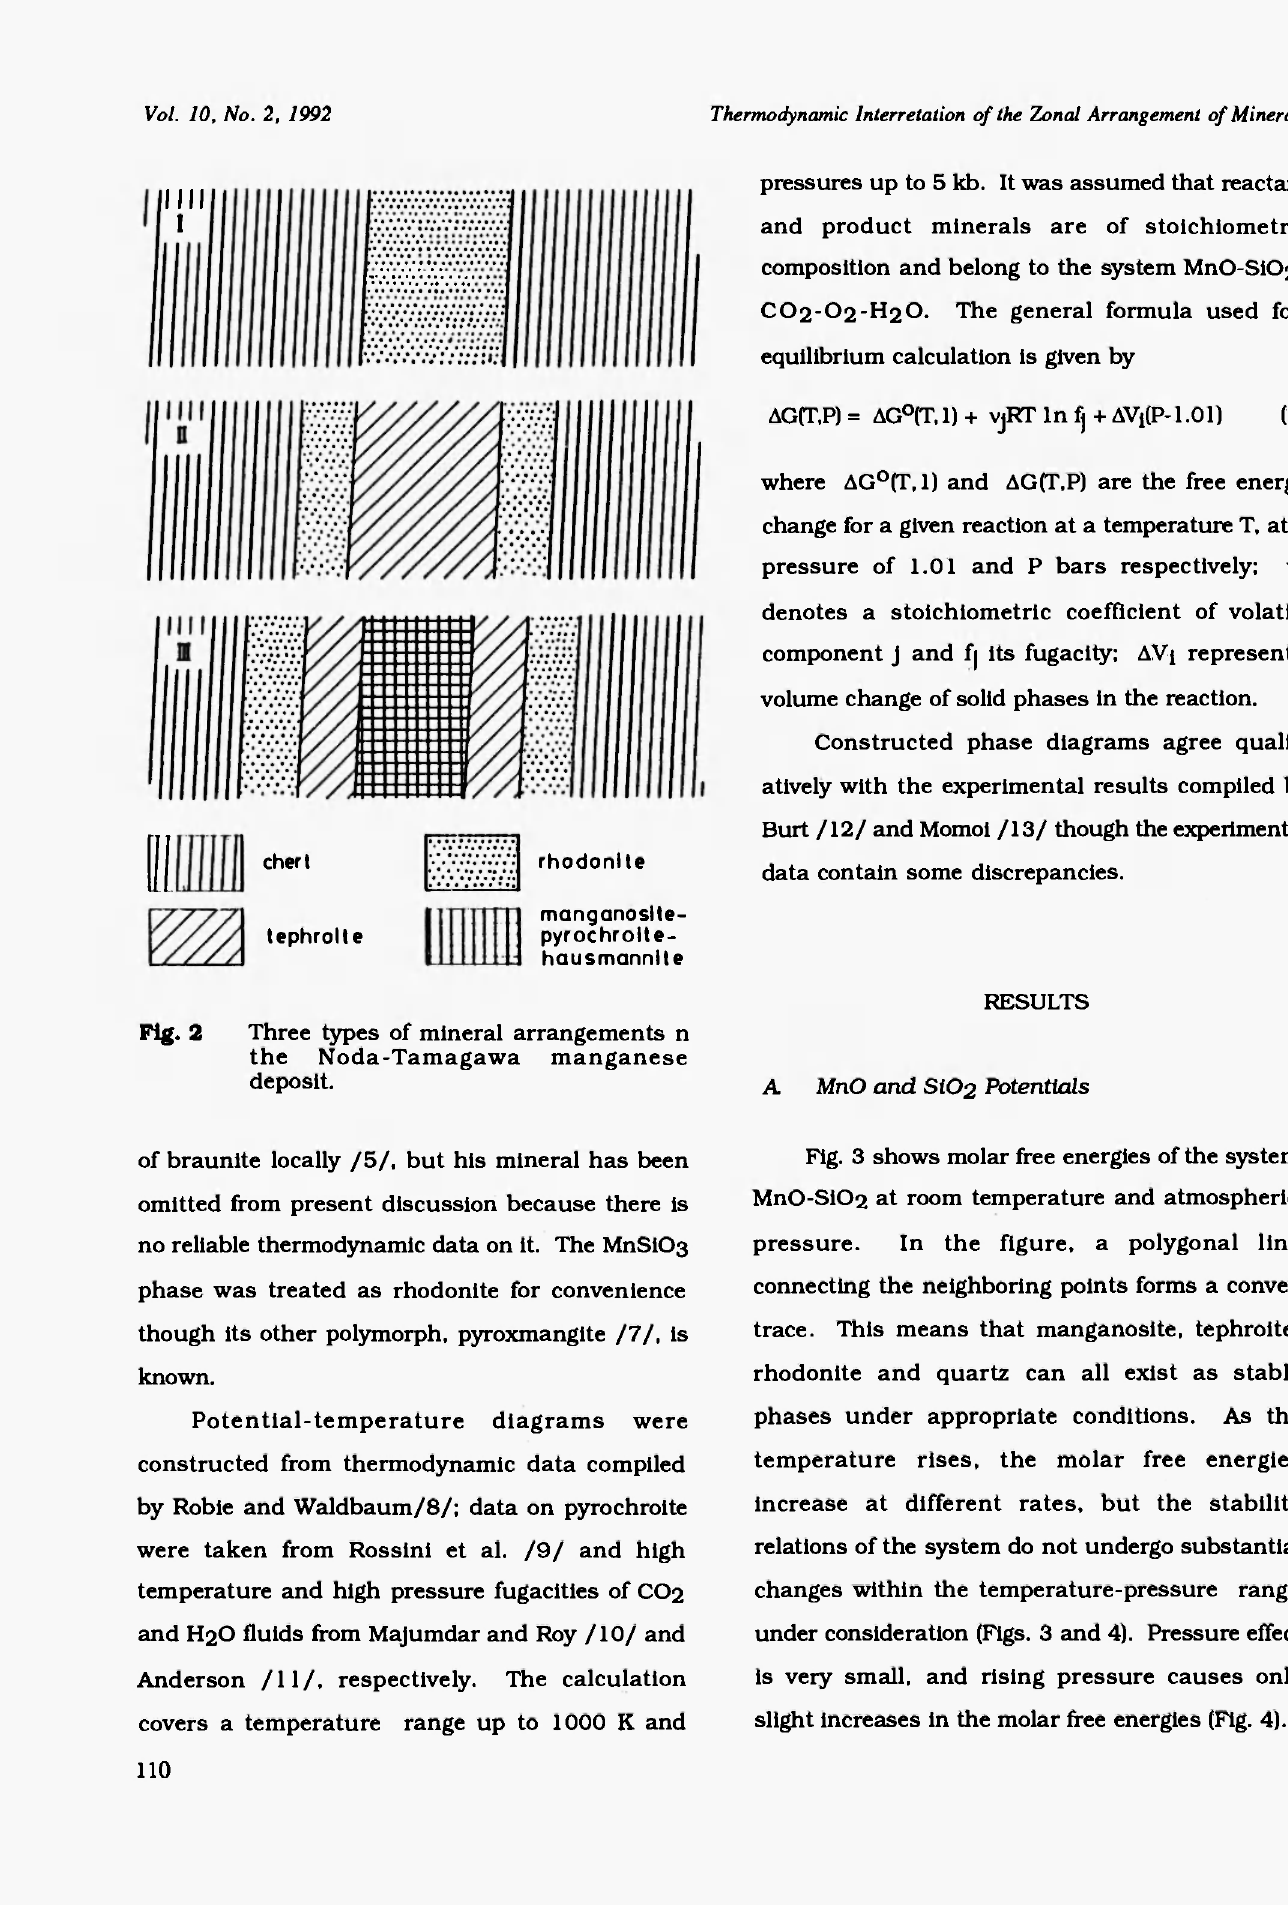
Fig. 2 Three types of mineral arrangements η the Noda-Tamagawa manganese